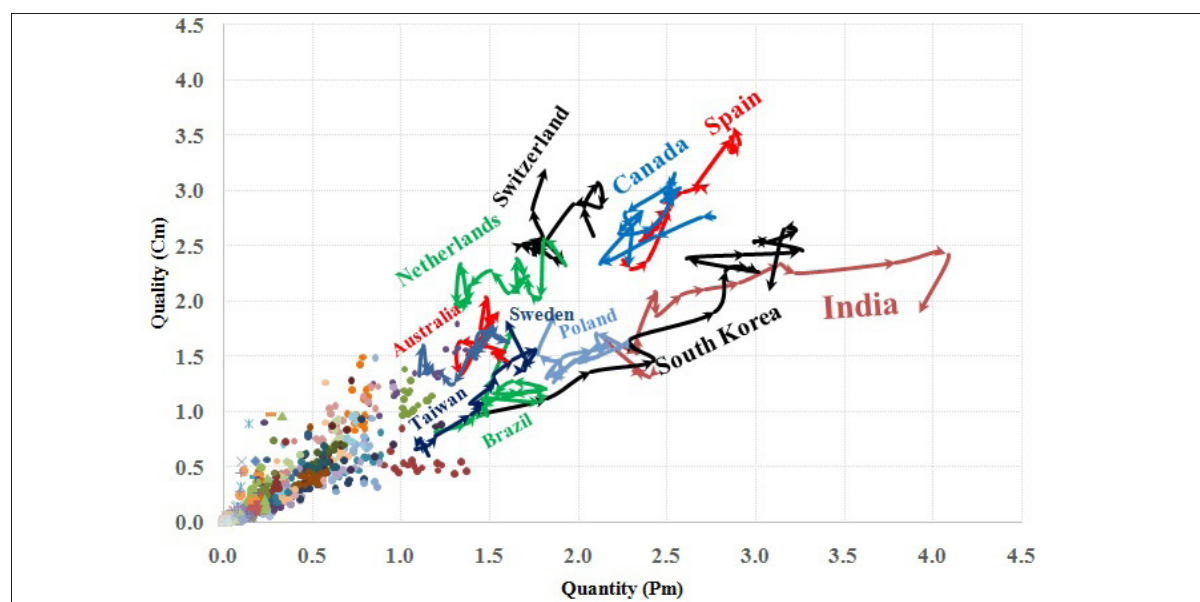
Figure 5: Pm-Cm diagram for ten highly active